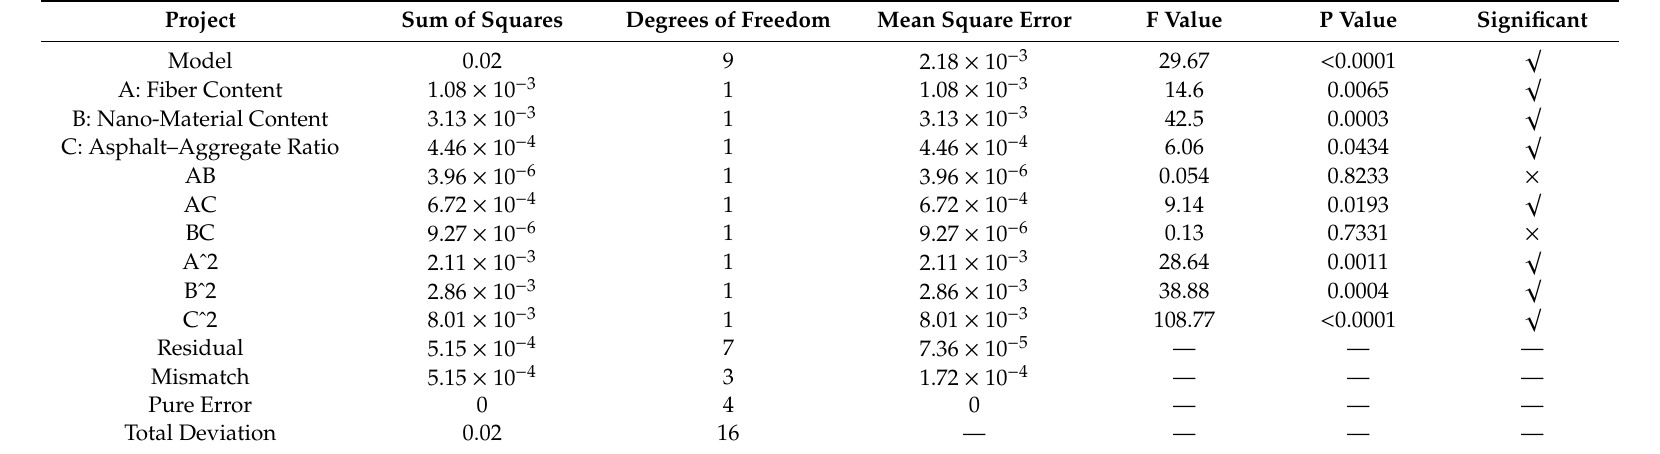
Table 14. Density variance